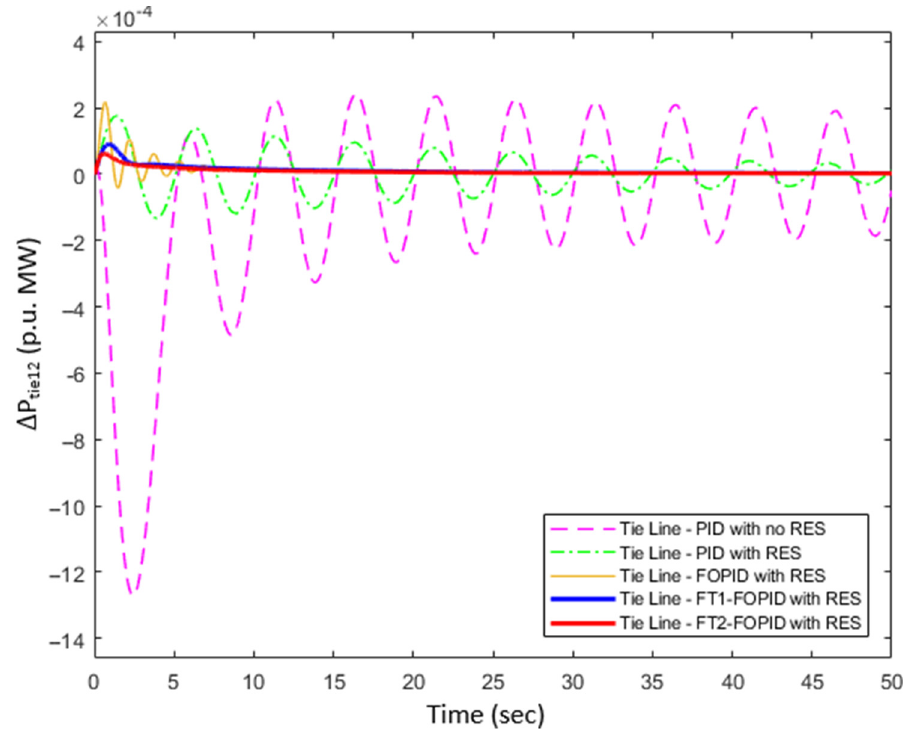
Figure 16. Results for 1% and 2% load alteration in Tie Line.